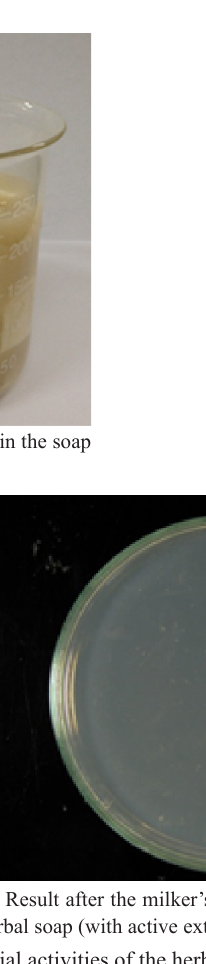
Figure 2 - In vivo antibacterial activities of the herbal soap with the active extract of P. ornatus in the milkers’